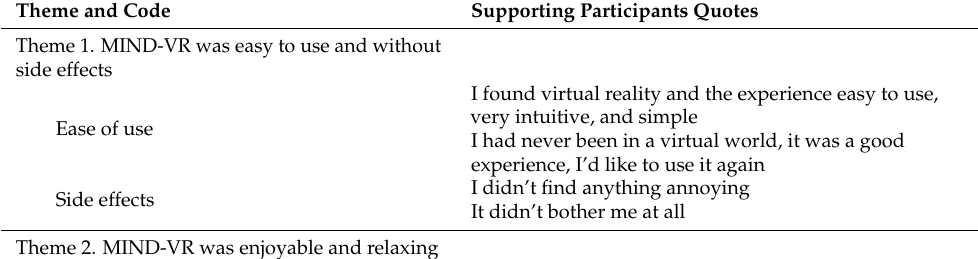
Table 5. Overview of themes and codes, as well as supporting participants’ quotes (N =